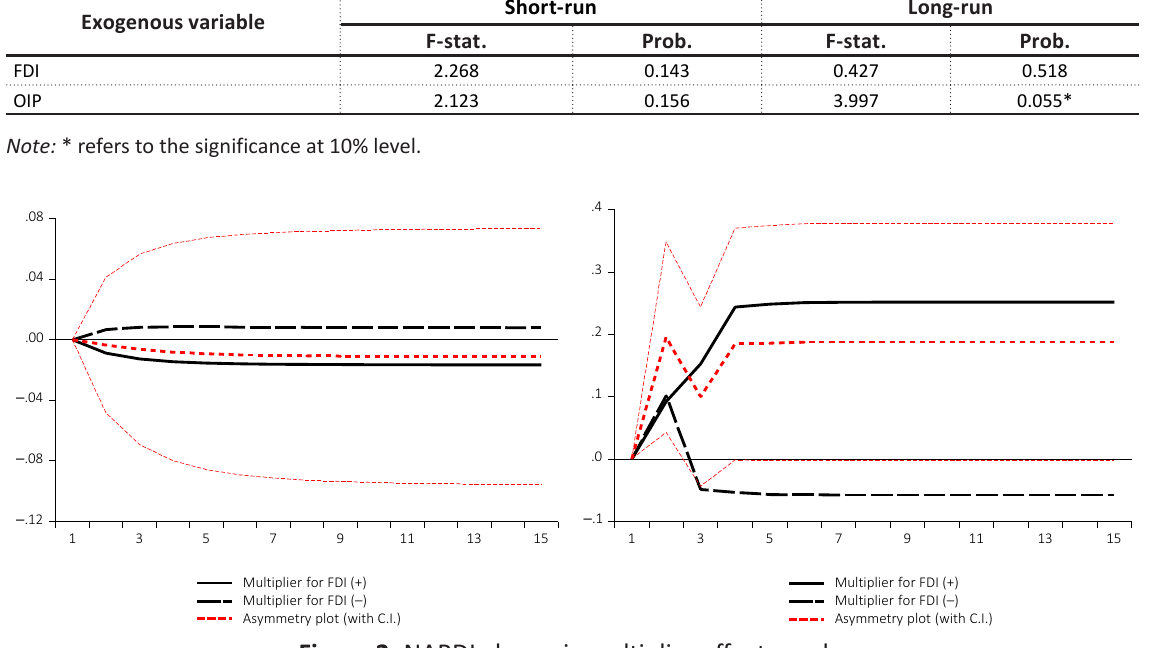
Figure 2. NARDL dynamic multiplier effect